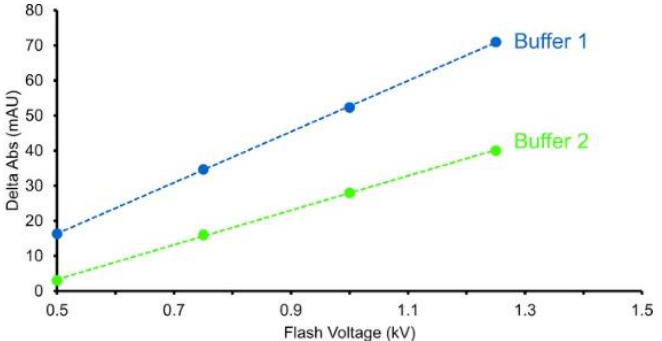
Figure 5. Adenine decreases 285 nm UV absorbance. The change in 265 nm absorbance is shown for different flash voltages and for two buffers. Buffer 2 contains a radical scavenger which decreases the change in adenine absorbance compared with buffer 1. Increased flash voltage is required to overcome the radical scavenging effects of buffer 2. Figure is adapted from [47], used with permission.